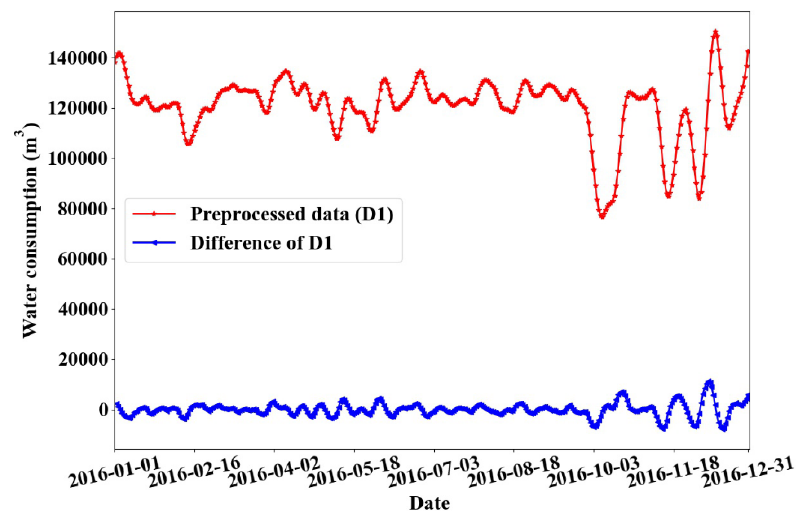
Figure 6. The original and first-order difference of total water consumption at the monitoring point 1.